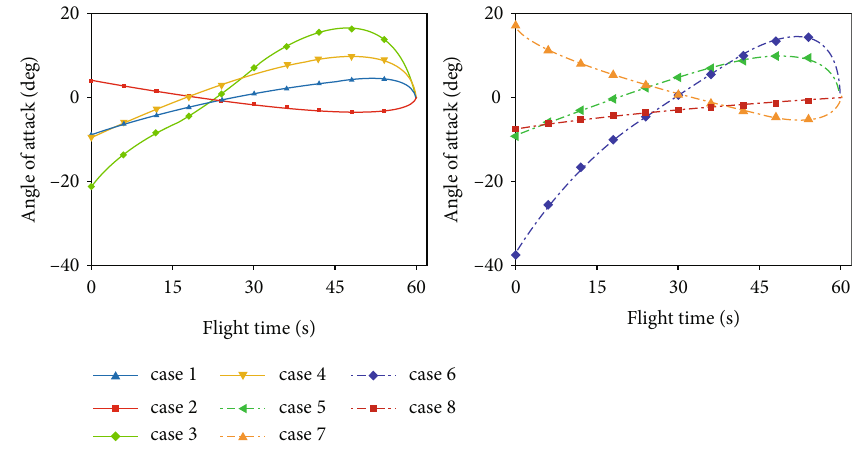
Figure 8: AOA pro fi les for di ff erent cases.